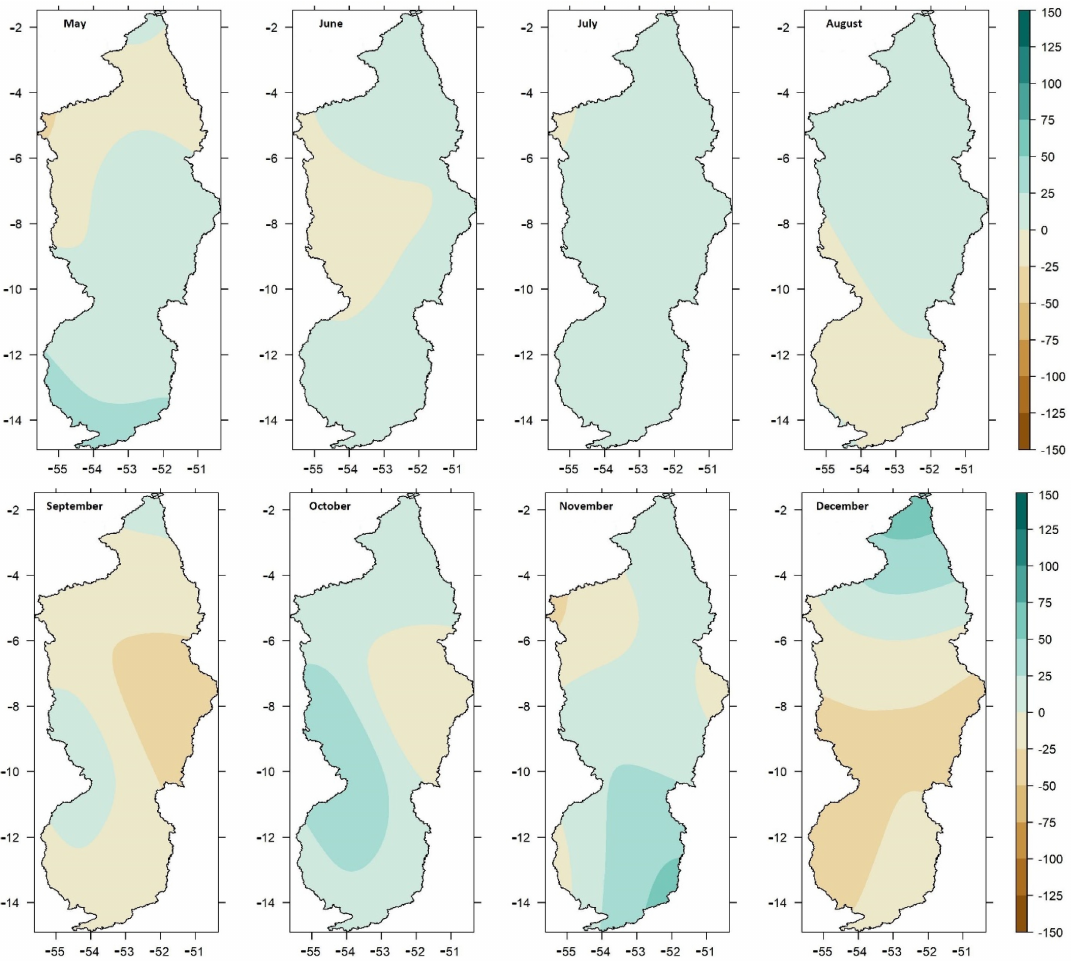
Figure 5. Differences in the climatology of the monthly precipitation over the XRB between the ensemble simulations and the observed data (ensemble minus observation), in mm/period, for the 1979–2010